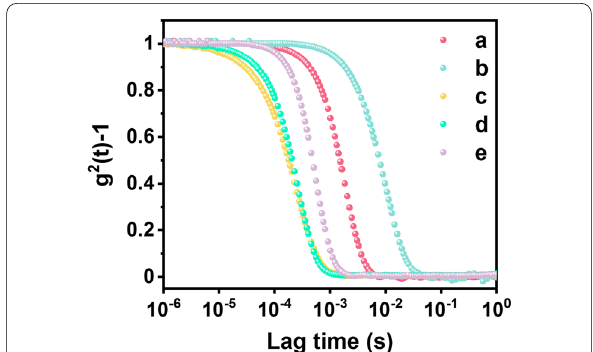
Table 4 Quantum chemical calculations of molecular models